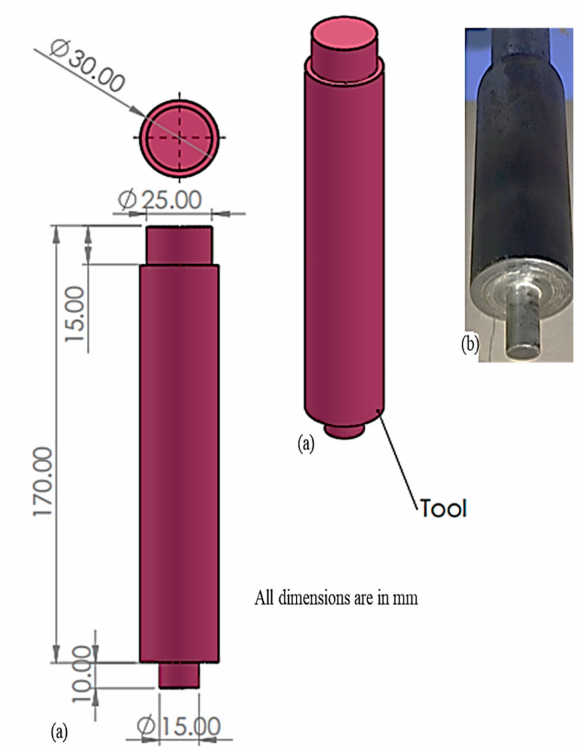
Figure 3. The FWTPET + FSP processing tools: ( a ) dimensions; ( b ) photograph.